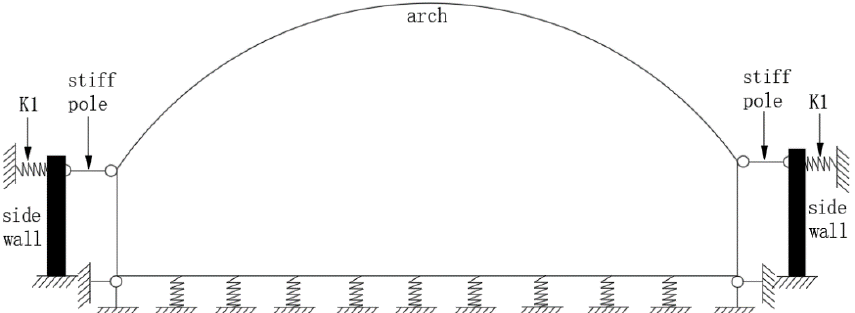
Figure 9. Simplified sketch. K1 is the horizontal soil spring;arch is the The arch is the lined super- structure;side wall is the hypothetical canal structure.